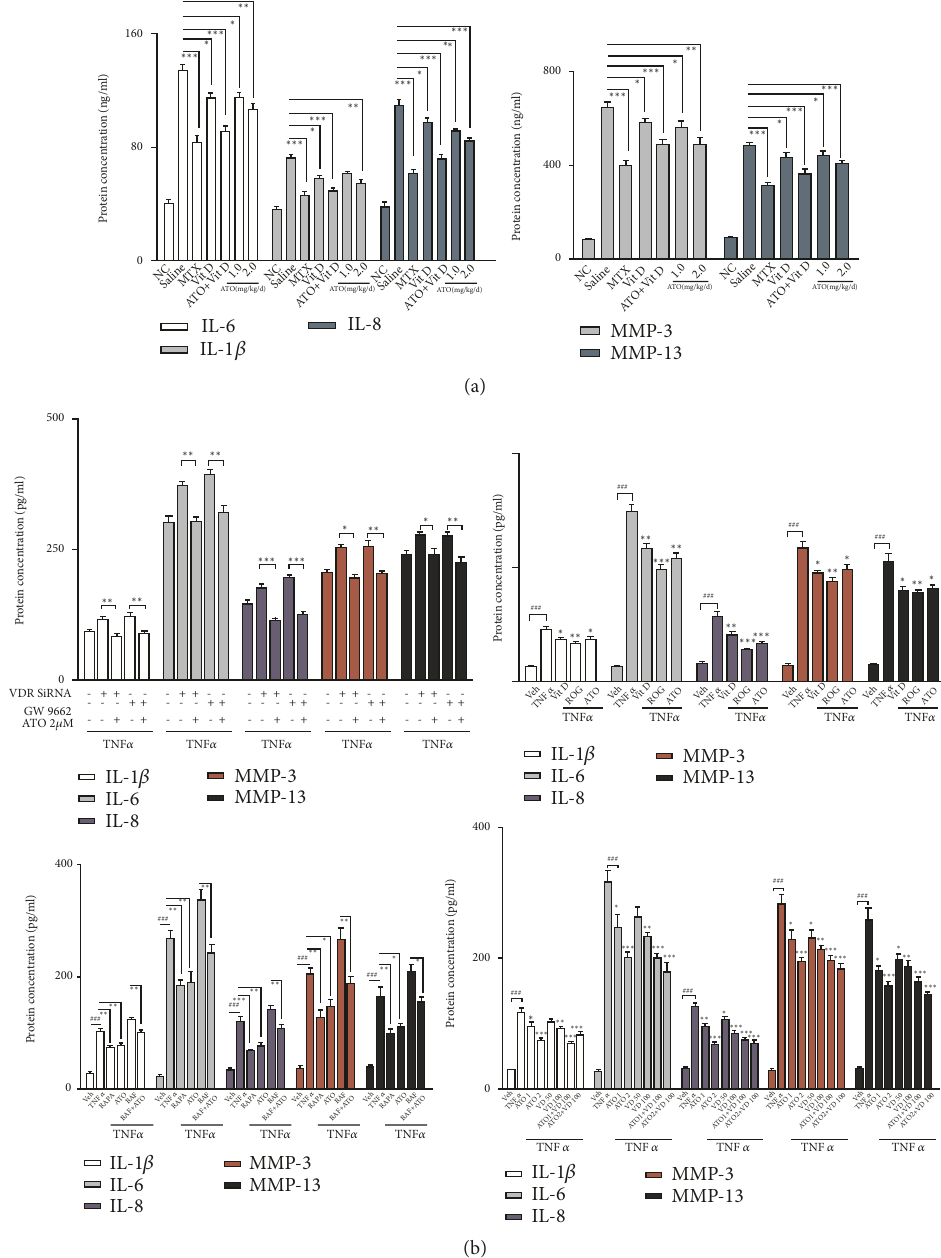
Figure 4: Arsenic trioxide (ATO) suppresses the release of key inflammatory and catabolic cytokines in rheumatoid arthritis (RA) . (a) Inflammation module representativesincludinginterleukin-6(IL-6), IL-1 𝛽 , and IL-8 and catabolism module representativesincluding matrix metalloproteinase-3 (MMP-3) and MMP-13 decreased in mice serum after the administration of ATO compared with collagen-induced arthritis- (CIA-) saline, whereas they significantly increased in CIA-saline mice compared to normal controls (NC), as shown by enzyme- linked immunosorbentassays (ELISA) ( n =6; ∗ p < 0.05; ∗∗ p < 0.01; ∗∗∗ p < 0.001).(b)Theadministrationof 2.0 𝜇 MATO significantly decreased the expression of inflammation module representatives and catabolism module representatives induced by tumor necrosis factor– 𝛼 (TNF- 𝛼 ) (50ng/mL) or by silencing the Vitamin D receptor (VDR) by small interfering RNA (siRNA) and inhibiting PPAR- 𝛾 with GW9662 ( n =3, # p < 0.05; ## p < 0.01; ### p < 0.001, vehicle versus TNF; ∗ p < 0.05; ∗∗ p < 0.01; ∗ ∗ ∗ p < 0.001, experiment versus TNF. Vehicle = RA fibroblast-like synoviocytes(FLS)withmedium;TNF=RAFLSwithTNF- 𝛼 treatmentalone).Inaddition,thesecytokinesweredownregulatedbyrapamycin and upregulated by BafA1 but this was reversible by ATO ( n =3, ∗∗ p < 0.05; ∗∗ p < 0.01; ∗ ∗ ∗ p < 0.001). ATO had synergistic effects with Vit D in downregulating the expression of IMRs and CMRs ( n =3, # p < 0.05; ## p < 0.01; ### p < 0.001, vehicle versus TNF; ∗ p < 0.05; ∗∗ p < 0.01; ∗ ∗ ∗ p < 0.001, experiment versus